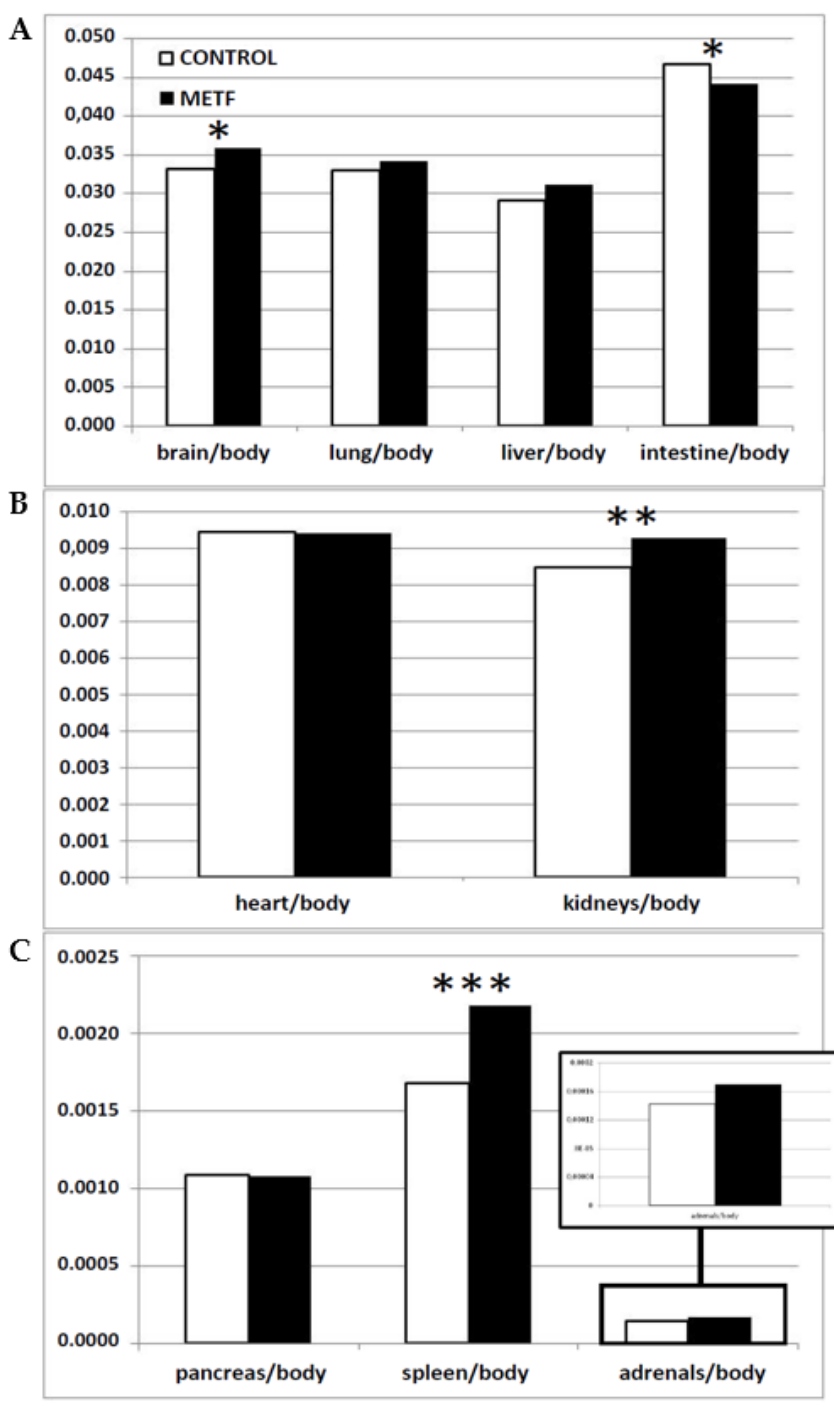
Figure 1. Mean values of weight ratios of brain, lung, liver, and intestine to total-body-weight ( A ), heart and kidneys to total-body-weight ( B ) and pancreas, spleen, and adrenals to total-body-weight ( C ) in controls (white bars) and maternal-metformin-treated fetuses (black bars). Asterisks denote significant differences (* = p < 0.05, ** = p < 0.005, *** = p < 0.0005). The maternal metformin therapy induced significant increases in the fetal plasma concentration of parameters indicative of glycemic (glucose and fructosamine, p < 0.005 and p < 0.0005, respectively) and lipid profile (triglycerides, p < 0.0005), without significant changes in total-, HDL-, and LDL-cholesterol), as shown in the Table